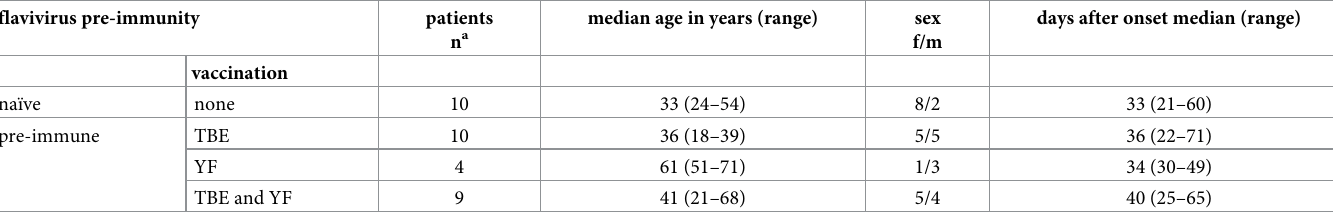
Table 4. Serum samples from flavivirus na ï ve and pre-immune Zika patients used for pools. flavivirus